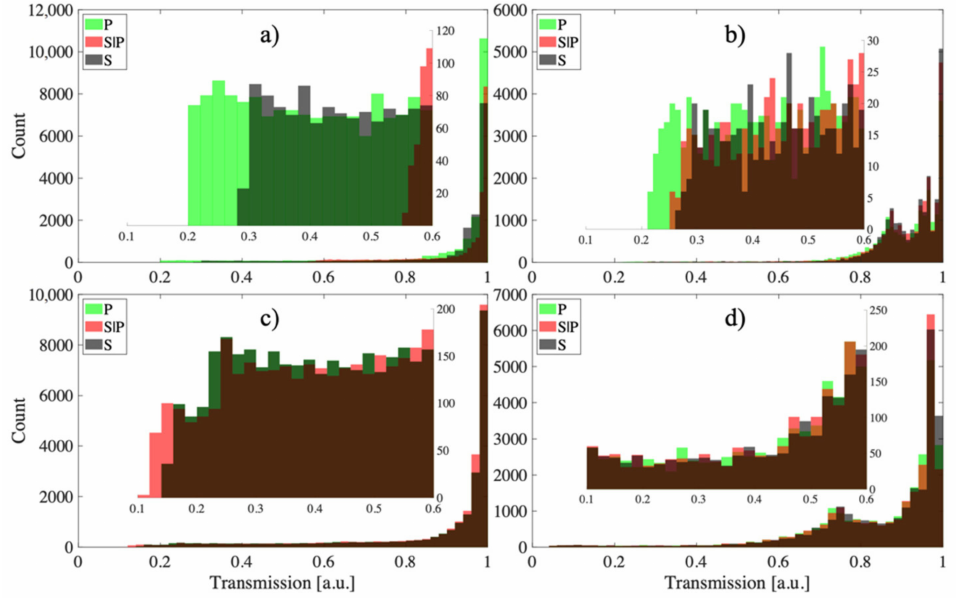
Figure 21. Histograms showing the response of the sensors to changes in P, S|P, and S polarization for the cases: ( a ) TFBG air, ( b ) TFBG solution, ( c ) P-TFBG air, ( d )